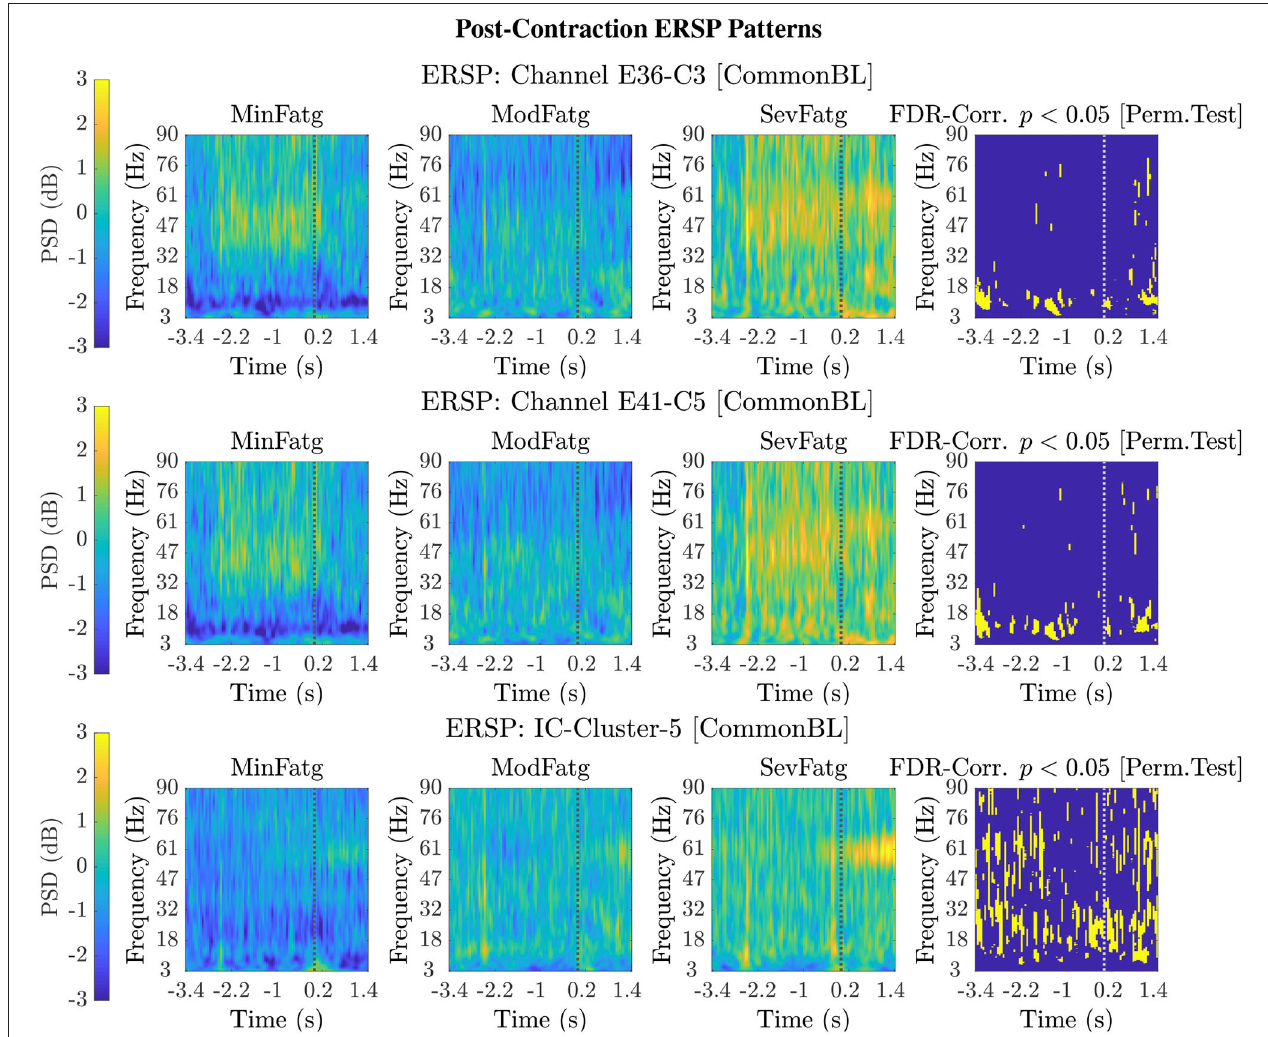
FIGURE 5 | Typical 2-D patterns ERSP FatgCond AVG for the EEG signals recorded during post-contraction with the scalp electrodes, C3 and C5, are shown in the top and middle row, respectively. The set of ERSP patterns displayed in the bottom row corresponds to IC Cluster 5 situated in the right paracentral lobule. The ERSP patterns offer evidence for a monotonic increase in the theta-, alpha-, and beta-band PSD with fatigue. The FDR-corrected p -values less than 0.05 threshold from the permutation test are depicted in the last column to indicate the statistical significance. The dotted vertical line in each ERSP pattern represents the offset of the elbow flexion task.